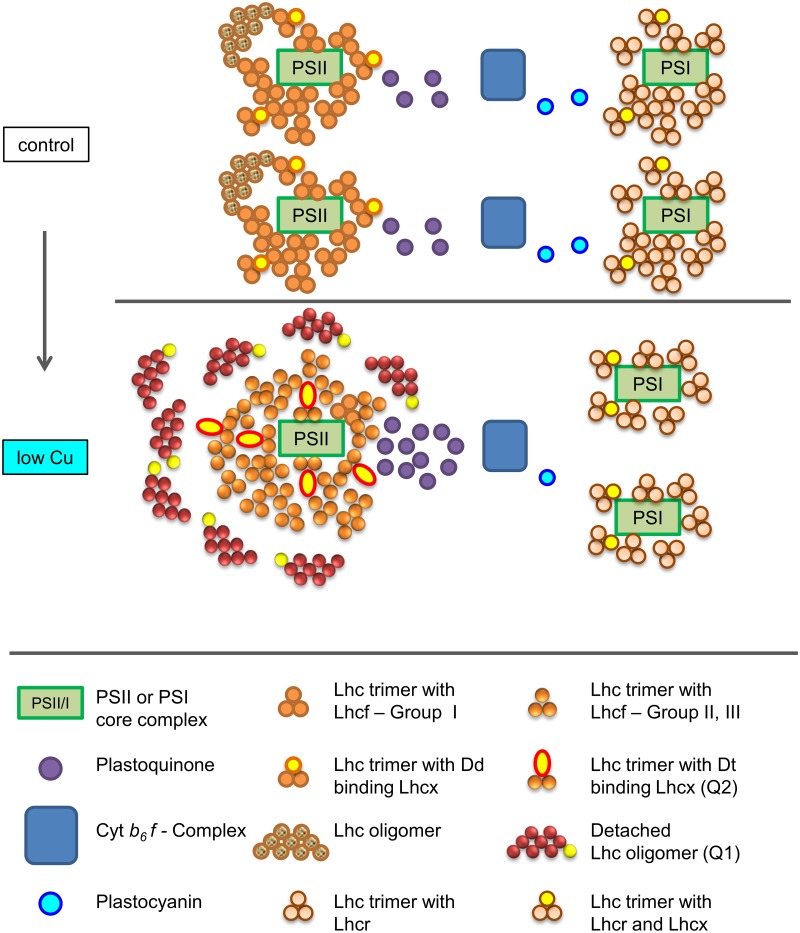
Model of the changes of the photosynthetic apparatus in T. oceanica (CCMP 1003) in response to growth in the presence of low Cu compared to optimal Cu levels (control).In the process of acclimation to low Cu concentration, several structural rearrangements take place in the photosynthetic apparatus allowing maximal photosynthetic efficiency and minimal photoinhibition. In our model, the represented changes in the numbers of LHCs, protein complexes and electron carriers are a reflection of the changes we observed in the proteomic data (see Table 3 for details): Overall cellular concentrations of proteins associated with PSII, and the photosynthetic electron transport chain (PSII, cytb6f complex and plastocyanin) decrease, whereas those associated with PSI remain unchanged, and the size of the plastoquinone pool increases. In general, cellular Chla concentration stays constant with an increase in the absorption cross section σPSII. NPQ increases dramatically as reflected in both a) quenching sites Q1 and Q2 located in detached oligomers (DLHCs) and b) trimers with diatoxanthin (Dt) binding Lhcx that are bound to PSII, respectively (NPQ response adapted from [97]). Approximate pigment content per LHC monomer is 8 Fucoxanthin, 4–6 Chla, 2 Chlc (as per [98]). For more details see “Proteomic shift within the photosynthetic apparatus in TO03” in the discussion.